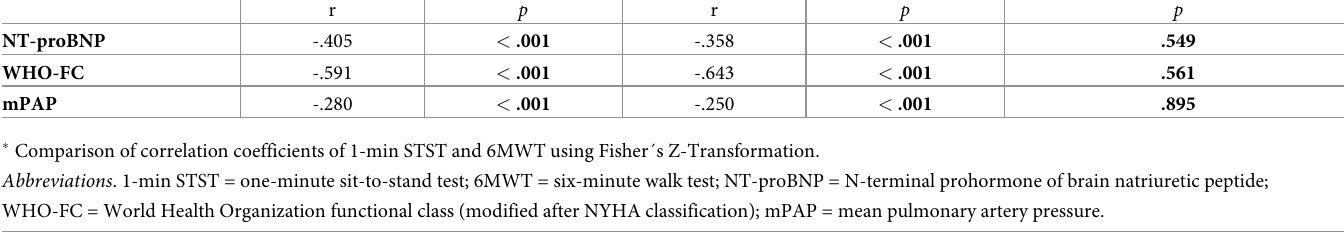
visualized in Fig 2 . Additionally, mPAP showed a negative correlation with 1-min STST repe- titions (r = -.280, p < .001) and 6MWD (r = -.250, p < .001). No statistically significant differ- ences between the correlation coefficients of the tests with PH severity markers were found (all p > .05).